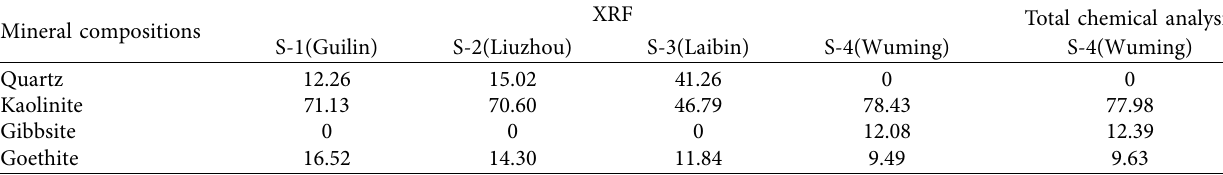
Table 6: Analytical results of the mineral compositions.